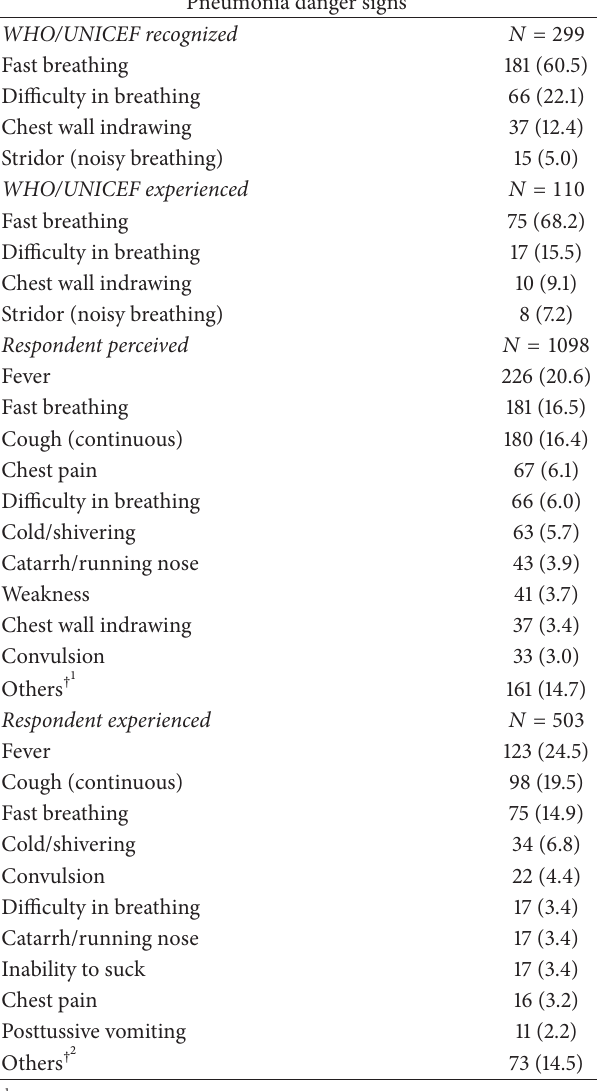
Table 3: Knowledge of pneumonia danger signs by respondents (multiple responses